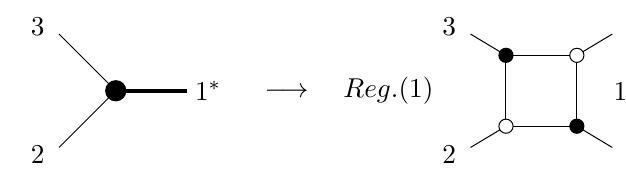
Figure 1 . O(cid:11)-shell 3-point vertex A (cid:3)